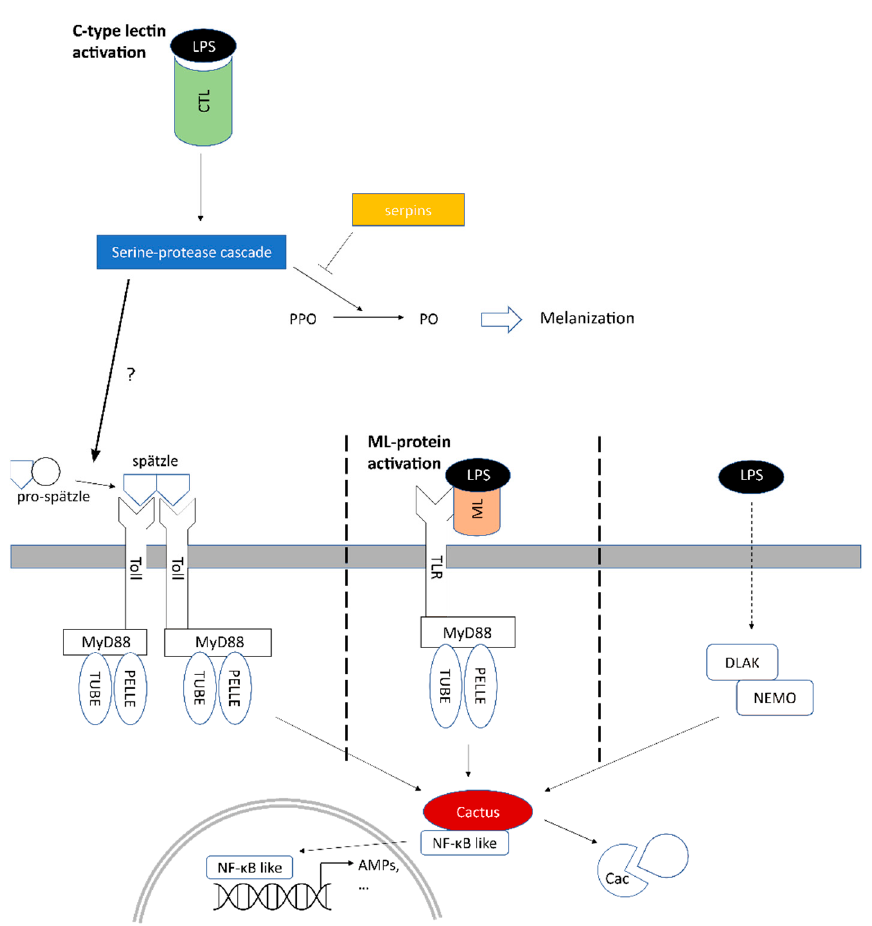
Figure 4. Schematic general overview of the immune pathways leading to the LPS-dependent modulation of NF-kB signaling in B. rossius . Colored background of shapes denotes modulation of molecules by the 2 h LPS stimulation (black).